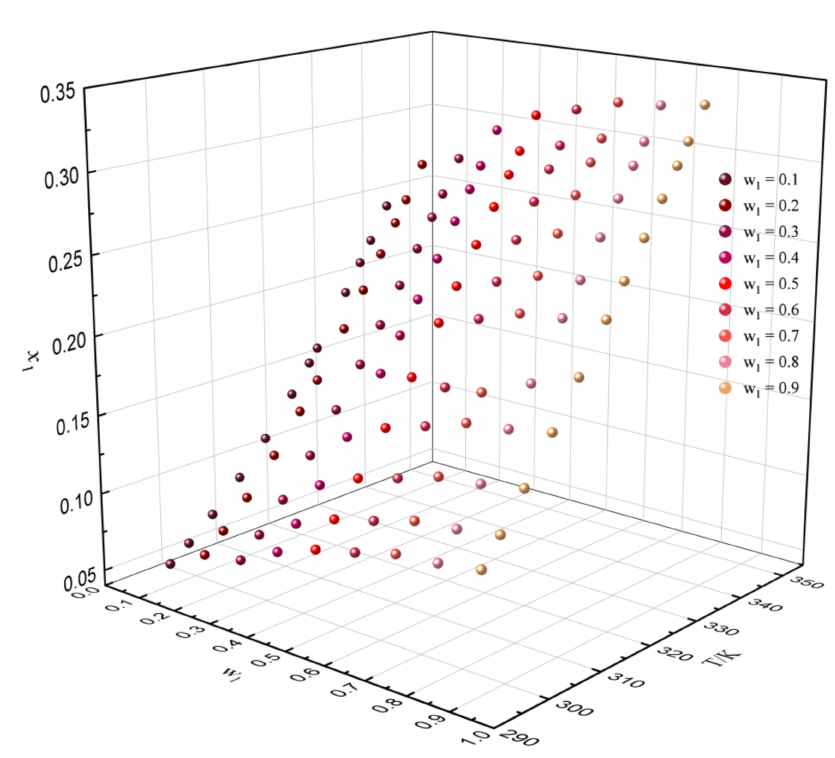
Figure 10. Solubility prediction data of dehydroabietic acid in the binary solvent of p-cymene (w 1 ) + ( − )- β -caryophyllene with various mass fractions at different